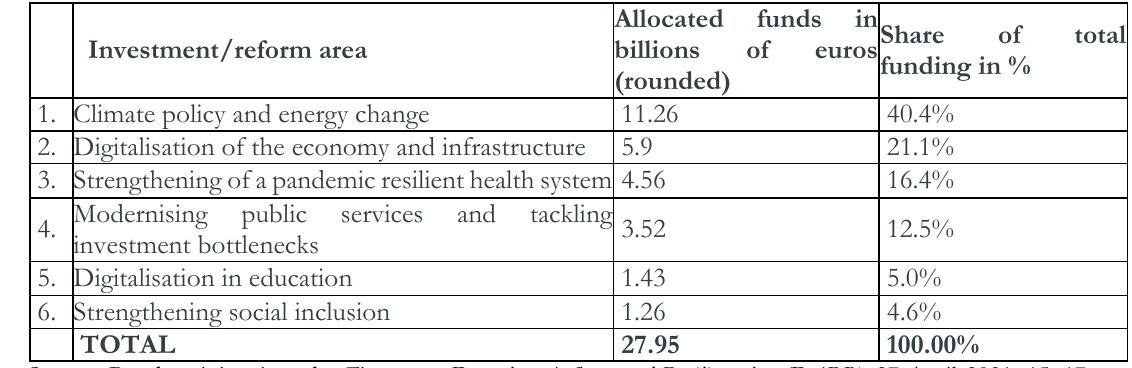
Source: Bundesministerium der Finanzen, Deutscher Aufbau- und Resilienzplan (DARP) , 27 April 2021, 15 –